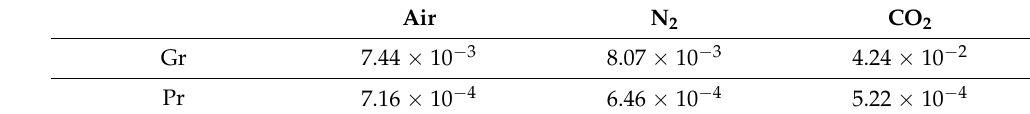
Table 2. Calculated Gr and Pr numbers.